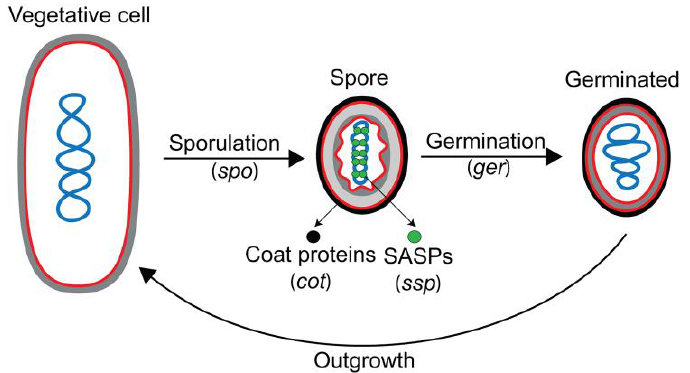
FIGURE 3: Developmental loci in B. subtilis . Diagram of the sporulation-germination cycle, with the different classes of developmental loci noted (in parentheses). The spo loci are required for spore formation, but not for vegetative growth. The ger loci are required for proper spore germination. After germination, metabolism is reactivated and the spore transforms into a growing vegetative cell in a process called outgrowth, which is thought to depend on the same path- ways that control vegetative growth. The cot and ssp loci were identified after the isolation and characterization of coat and small acid-soluble proteins (SASPs), respectively, from spores. In addition to the these categories, there are hundreds of developmentally-regulated genes whose roles in sporulation and germination are not yet understood. Membranes, red; DNA, blue; cell wall, gray; spore cortex, light gray; spore coat, black; SASPs, green